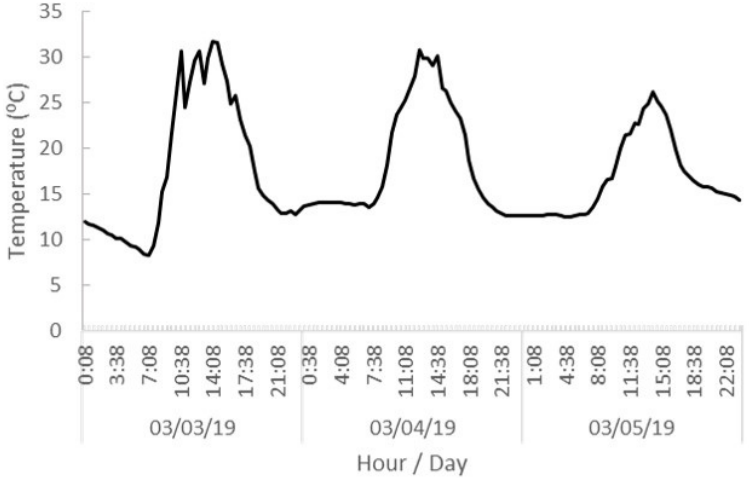
Figure 1. Diurnal changes in air temperature inside the greenhouse at the plant canopy level. The pattern illustrated is for temperatures measured from 3 to 5 March.